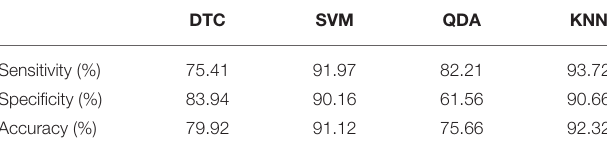
TABLE 4 | Values of sensitivity, specificity, and accuracy obtained for each classifier once the feature selection process had finished. DTC SVM